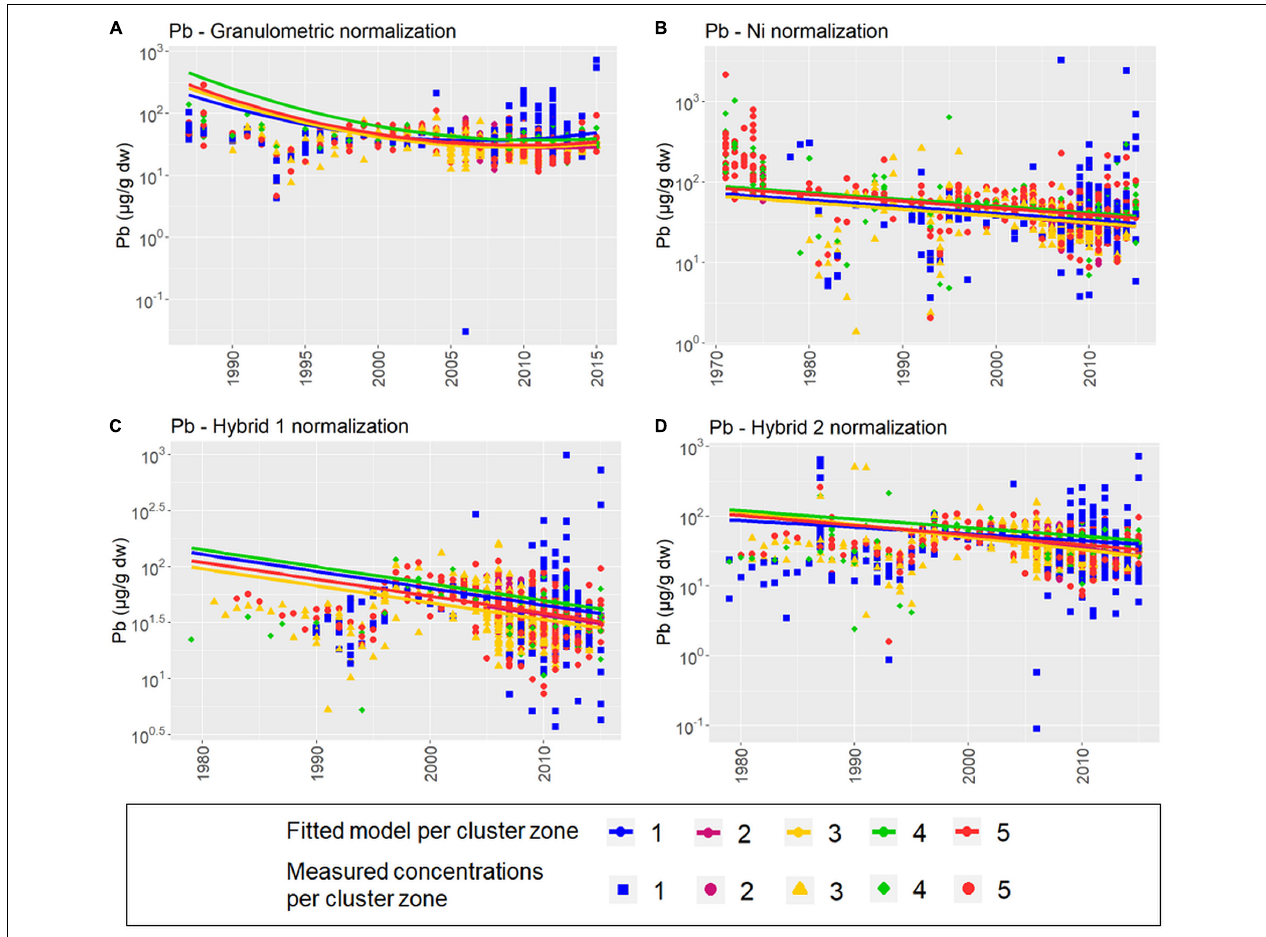
FIGURE 8 | Trends in log Pb in sediments of the BPNS, applying (A) granulometric normalization ( < 63 µ m, 1987–2015), (B) Ni normalization (1971–2015), (C) Hybrid method 1 (1979–2015) and (D) Hybrid method 2 (1979–2015). Data points represent the derived concentrations, after normalization. Colored regression lines represent the fitted time trends within each spatial cluster zone, scaled to the first quadrimester and to the most recent analytical method.